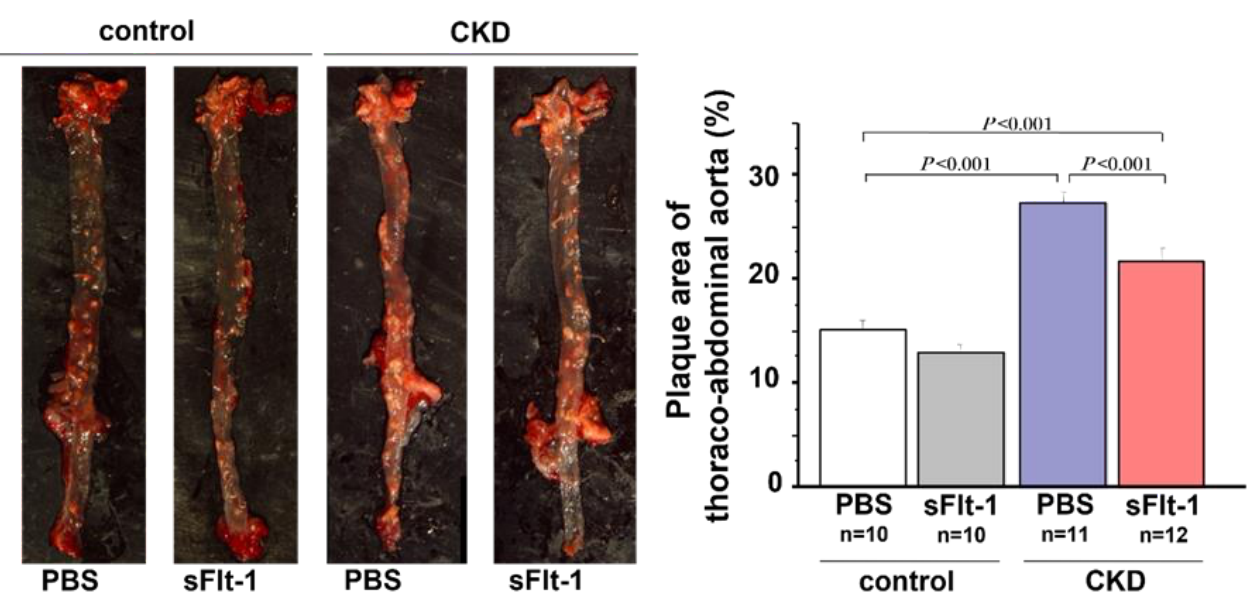
Figure 4. Aortic plaque formation in control or 5/6-nephrectomized Apo E KO mice. Plaque for- mation in the thoracoabdominal aorta was increased in a mouse remnant kidney model but reduced by repeated intraperitoneal injection of sFlt-1.